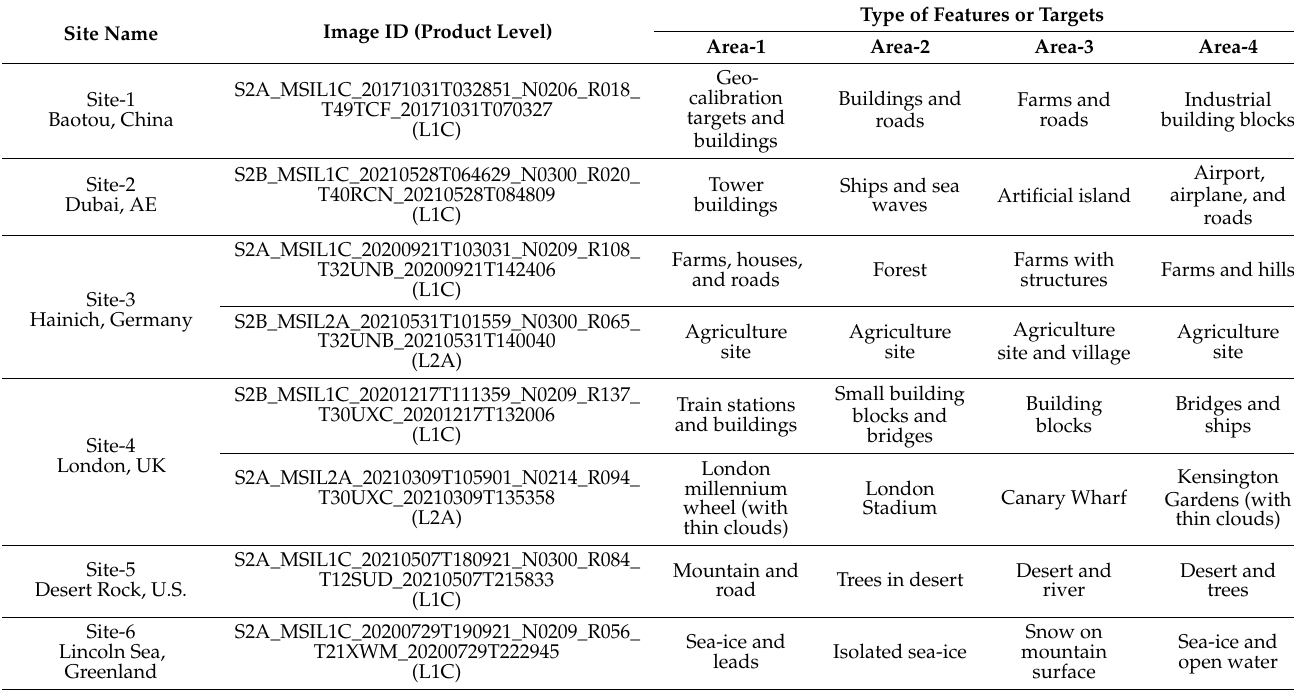
Table 2. Testing site, input Sentinel-2 image IDs (10 m/pixel TCI colour product), and containing